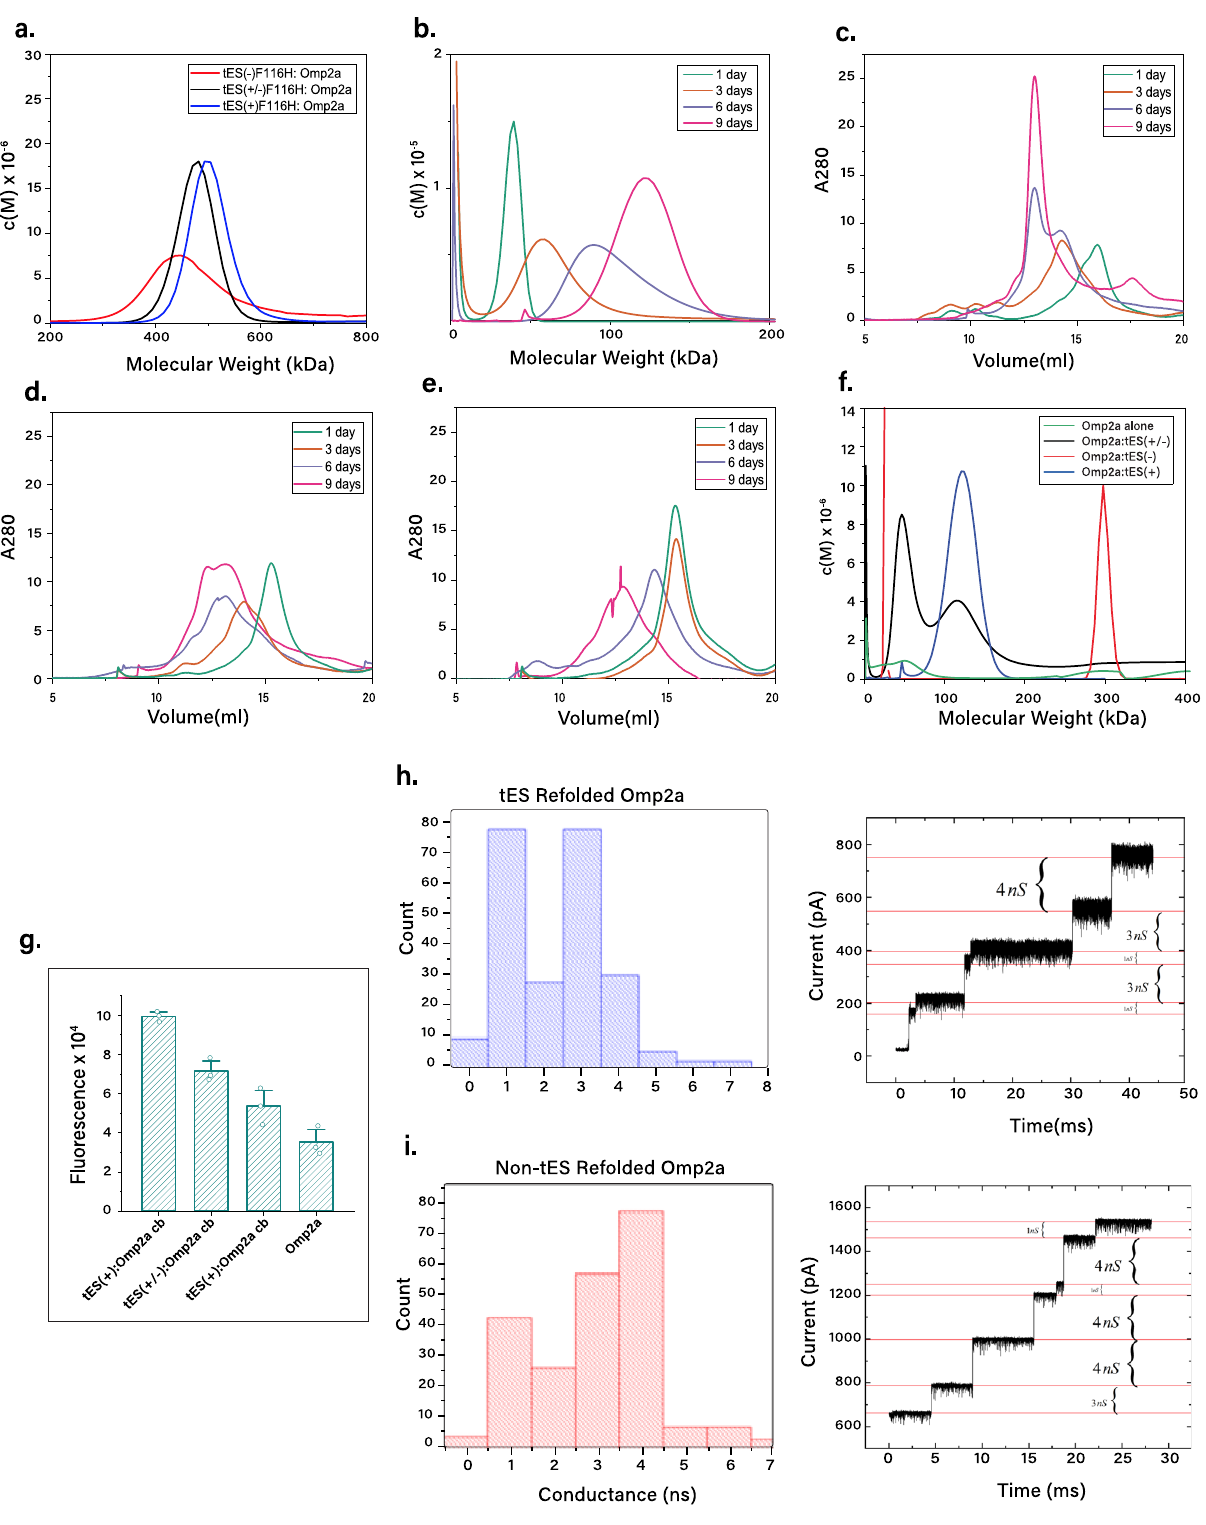
Fig. 5 Omp2a folding with tES – F116H. a tES – F116H( + ) encapsulates a single monomer of Omp2a ( b ) Omp2a monomers released from tES – F116H( + ) form trimeric assemblies after a nine-day incubation period. c , d , e SEC demonstrates complete trimerization only in the setting of tES116H( + )-mediated folding. f AUC demonstrates that the ability to form Omp2a trimers is affected by tES – F116H internal charge. Omp2a folded without tES – F116H does not demonstrate trimerization. g Intrinsic fl uorescence of Omp2a refolded and released from tES( + )F116H, tES( + / – )F116H, and tES( – )F116H, and Omp2a refolded without tES. (Data are presented as mean ± SEM., n = 3 independent experiments). h Conductance measurements of the 172-kDa Omp2a trimeric SEC fraction demonstrate a range of 1 – 4 nS. i A positive control of Omp2a demonstrates similar conductance insertions (Source data are provided as a Source Data fi